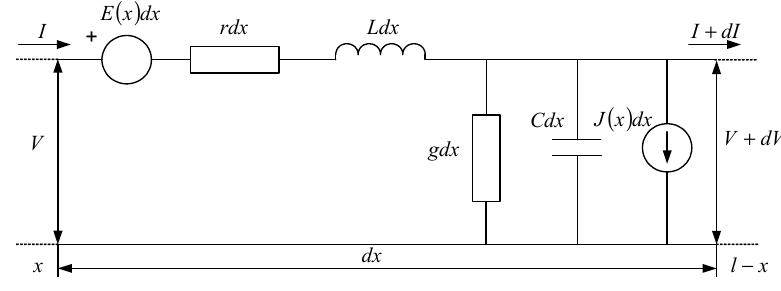
Figure 2. Equivalent circuit representing one-conductor transmission line lump.